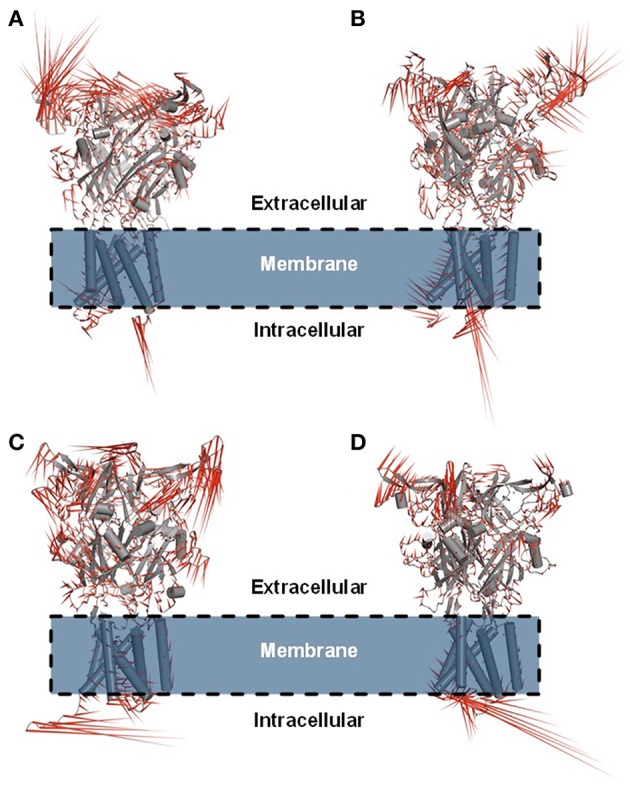
Porcupine plot showing the main concerted motions of the hP2X7R and mP2X7R structures in the hP2X7RAPO
(A), hP2X7R9f
(B), mP2X7RAPO
(C), and mP2X7R9f
(D) systems during the last 150 ns of molecular dynamics simulation.